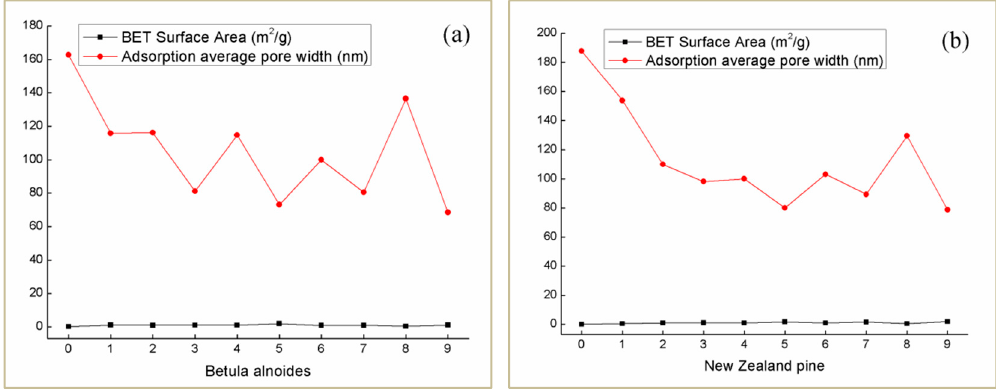
Figure 7. Surface area and adsorption average pore width of OW and FW for two tree species ( a ), ( b